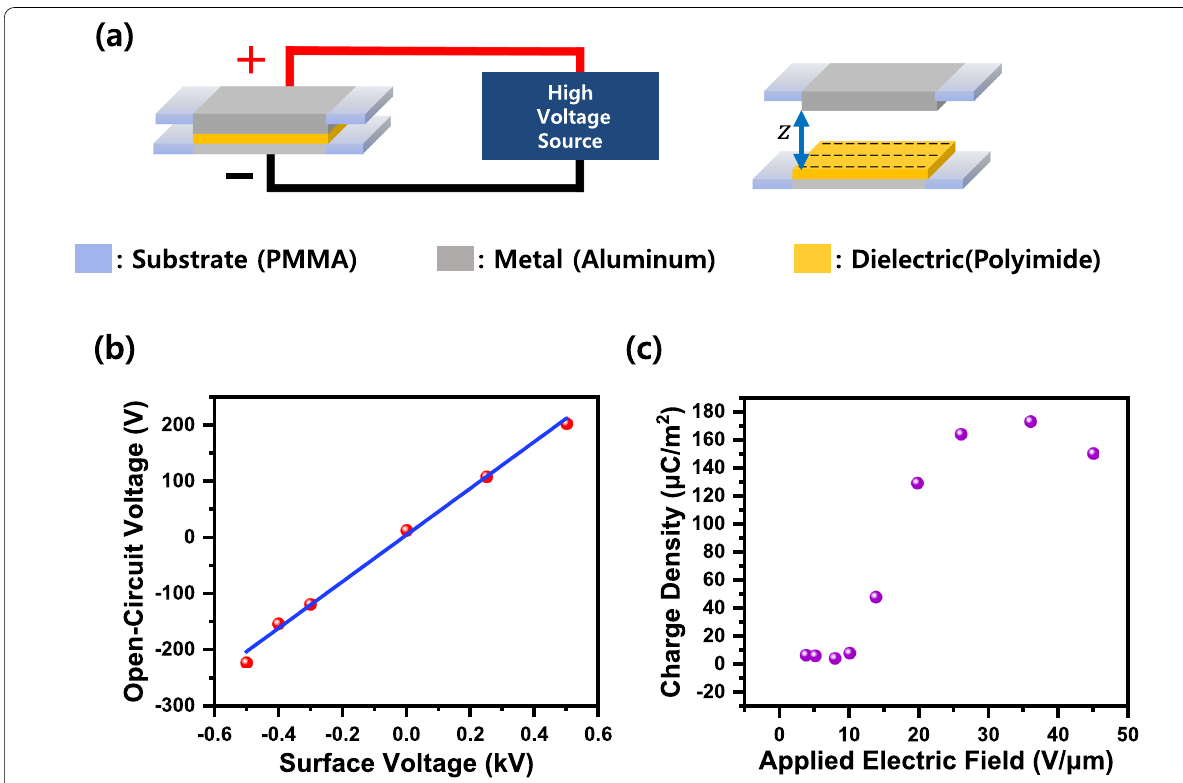
Fig. 1 a CS-TENG structure and dielectric surface charge injection method for the prior charge injection. b Output voltage depending on the surface charge density. c The relationship between the applied charge injecting electric field and the charge